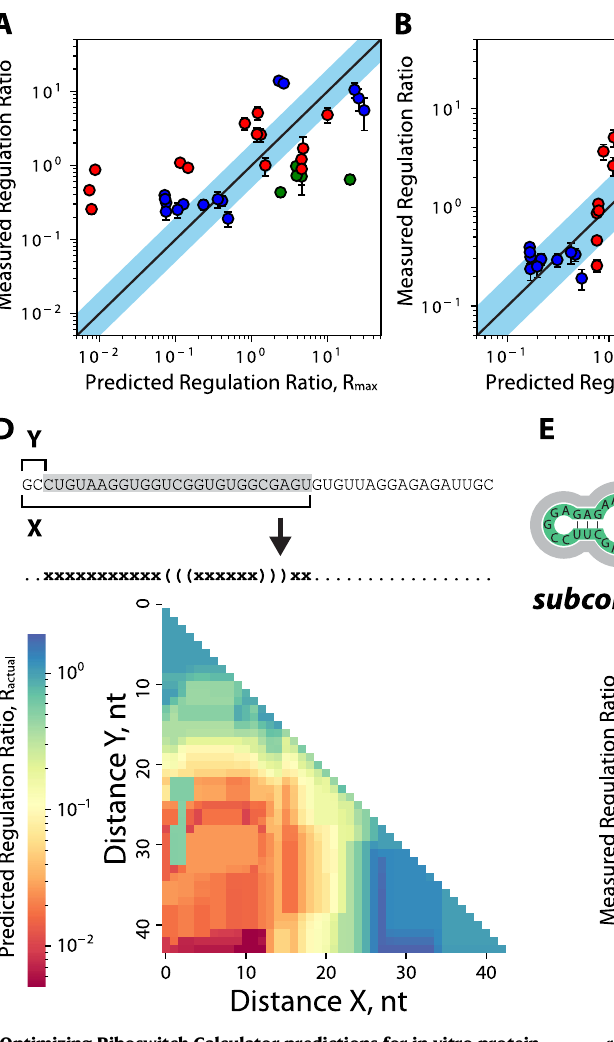
recalculated while systematically varying the length of the aptamer subconstraint region, showing riboswitch Co1 as an example. E The optimal aptamer sub- constraints for the MS2, mCRP, and IL32 γ aptamers were identi fi ed and utilized to predict the actual regulation ratio, R actual , for all riboswitches. Overall accuracy is R 2 =0.64, with 56% of riboswitches predicted to be within 2-fold of their measured activation ratio. Dots and error bars are the mean and standard deviation of data with 6 – 8 biological